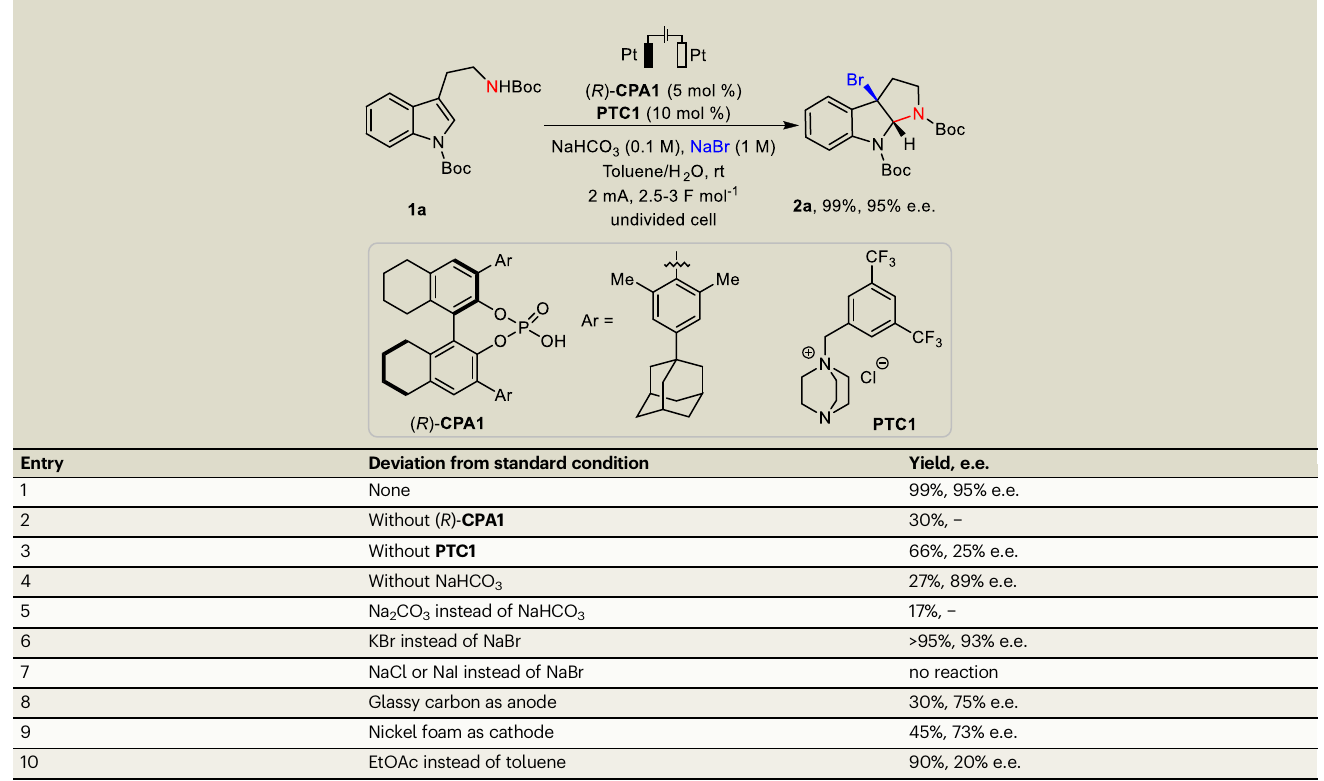
Detailed reaction parametersfortheoptimized conditions andthe reaction outcomesupon changingthe parameters.Reaction scale: 1a (0.1mmol),( R )- CPA1 (5mol%), PTC1 (10mol%),NaHCO 3 (0.1MinH 2 O),NaBr(1.0MinH 2 O),toluene(2mL),H 2 O(2.5mL),Ptanodeandcathode(10mm×10mm×0.2mm),stirringspeed:1000r/min,2mA,rt,4h. Boctert -butyloxylcarbonyl.Theyieldswere determined bycrude 1 H NMR analysis, ande.e.values were determined bychiral